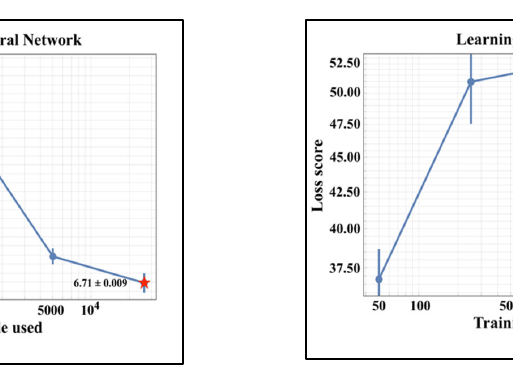
Fig. 3. The learning curve of ML methods shows the number of training examples of Unicode text data versus cross-entropy loss by algorithm processing. (a)-(e) display excellent learning as a low loss score. (f) shows poor learning results. The ML needed to minimize errors. The objective function could determine the error measurement and be often called loss score or mean cross-entropy loss. The loss score provided the best performances in terms of classification. The success of the model will almost always be higher on the training data set. It will return a lower mean cross-entropy loss of the model, including a lower error between the training set and validation set of learning curves. The ML learning text Unicode results found a low loss score below 7.95 ± 0.029 from Decision Tree, Logistic Regression, Markov, Naïve Bayes, Nearest Neigh- bors, and Neural Network method.